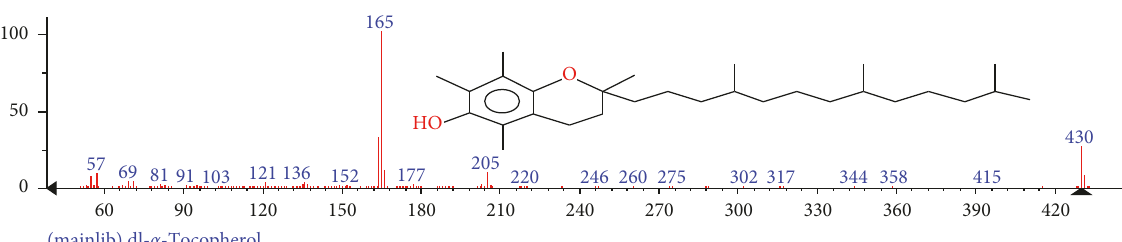
Figure 58: Mass spectrum of compound dl- α -tocopherol of whole plant hexane fraction of Achillea wilhelmsii (WHFAW).